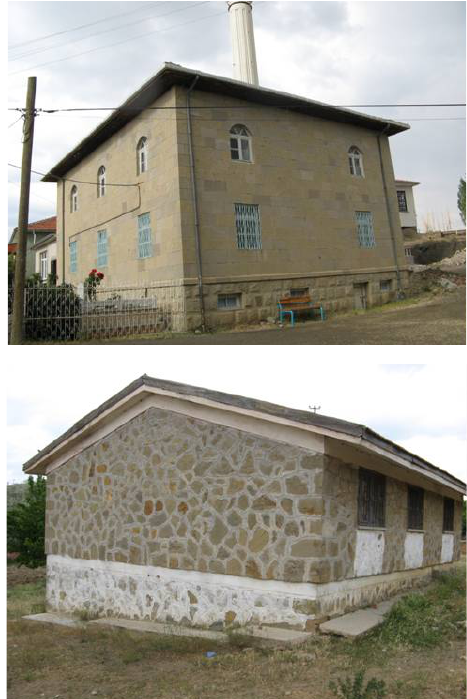
Fig. 22. Examples of undamaged masonry Fig. 22 Examples of undamaged masonry structures